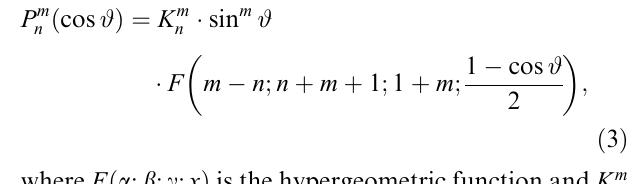
Table 1 for an example with #